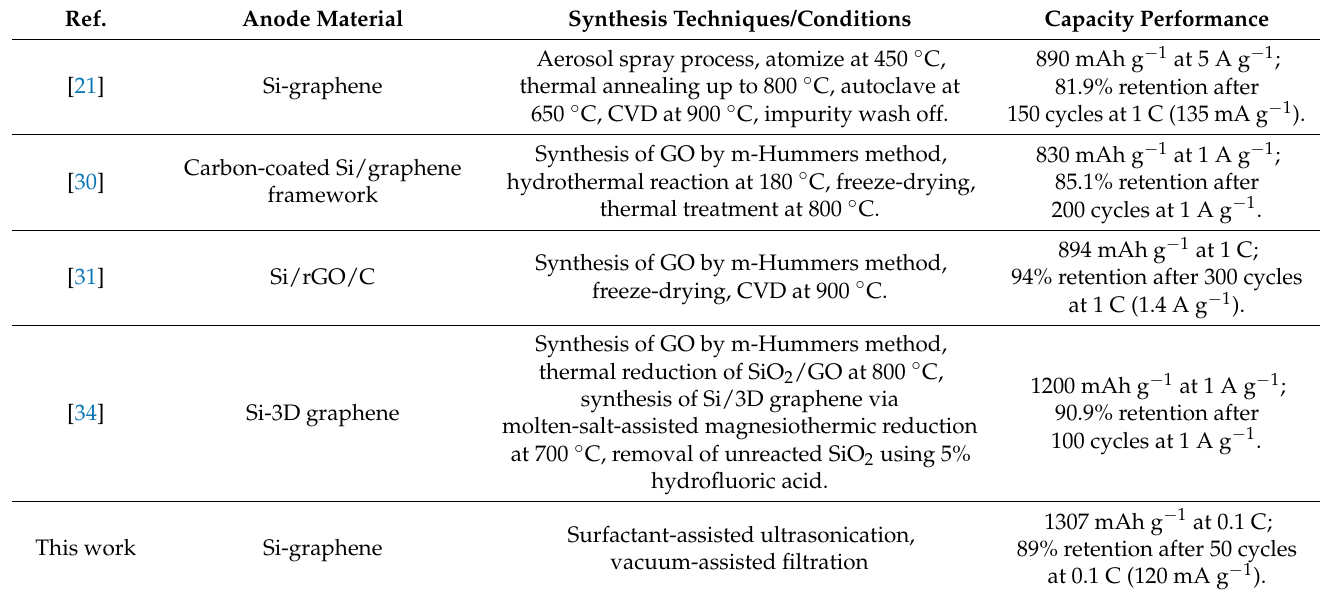
Table 2. Synthesis and capacity performance of Si/graphene related anodes from literature.